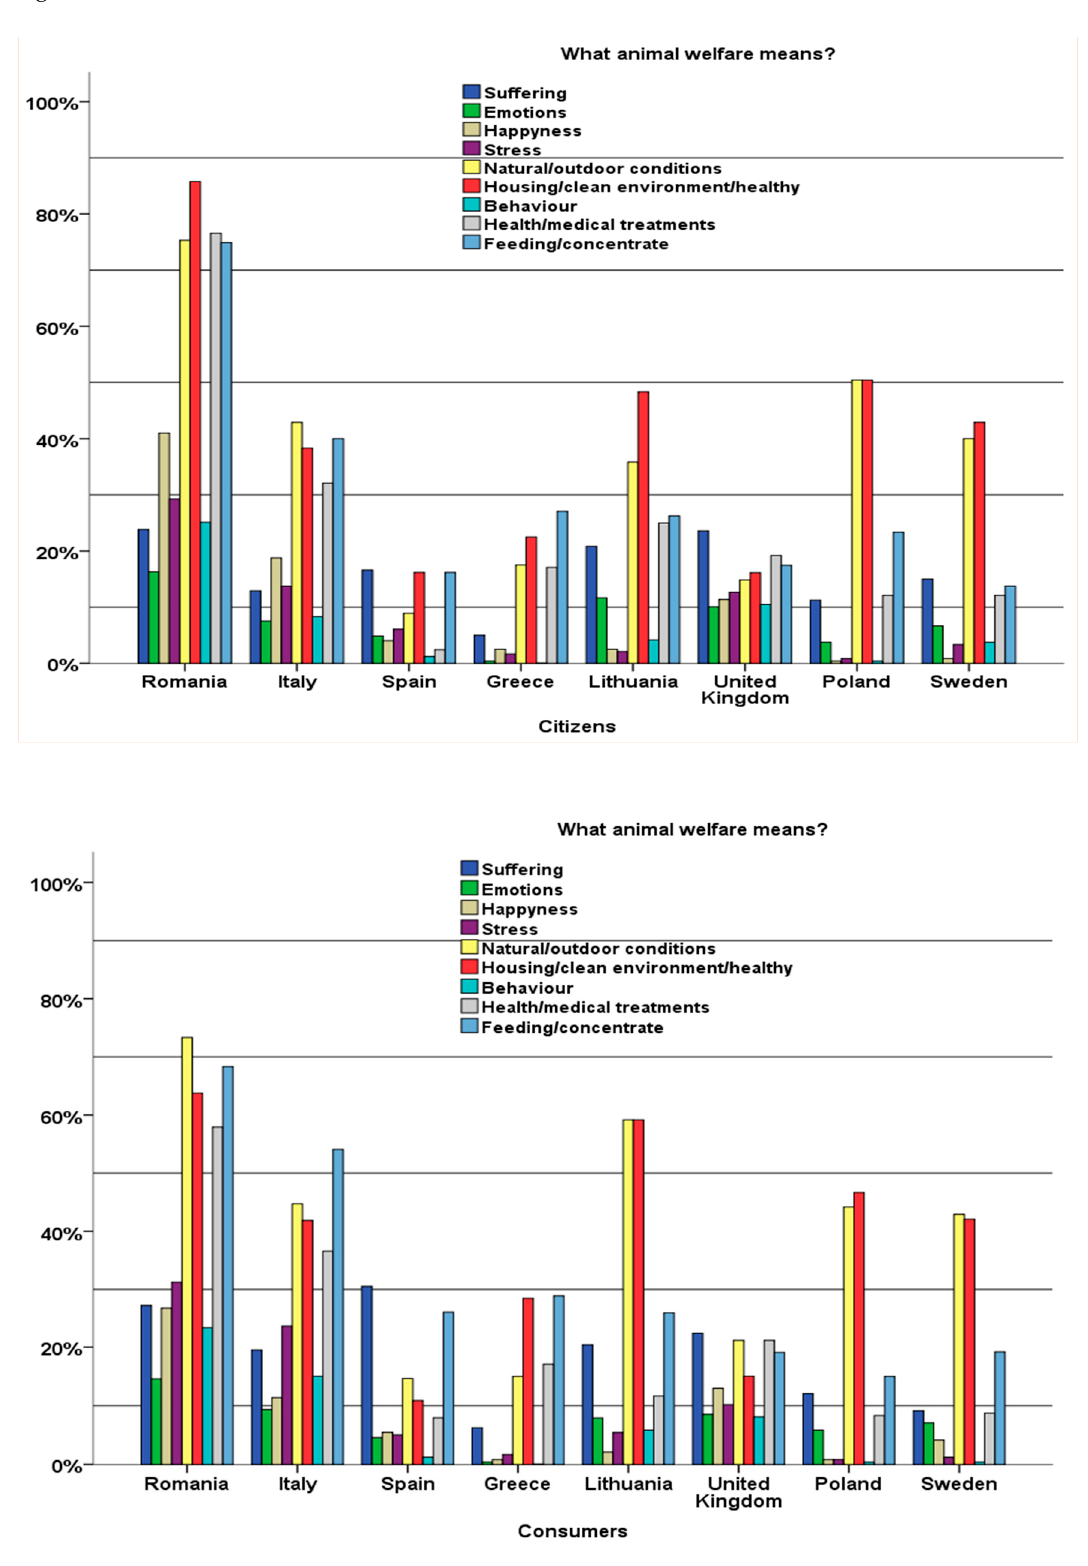
Figure 2. Animal welfare understanding of citizens and consumers.